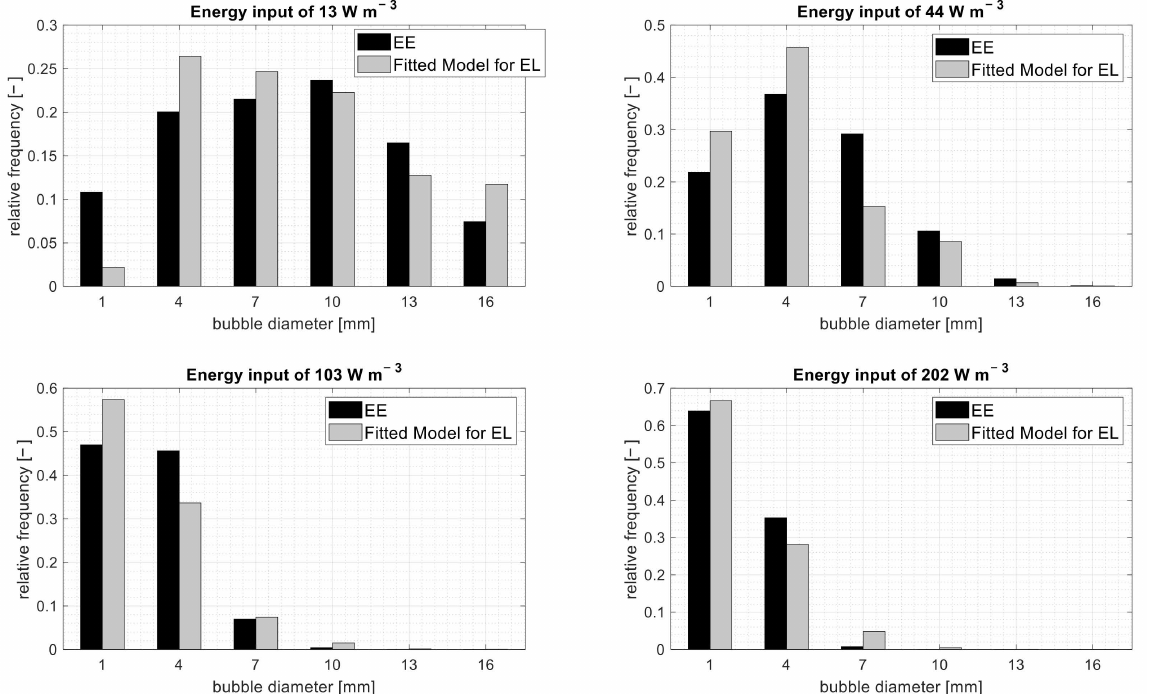
Figure 11. Comparison of the resulting bubble size distribution created with the Luo et al. [4] model in the EE approach (black) and the fitted model for EL (gray). Shown for energy input of 13, 44, 103 and 202 W m − 3